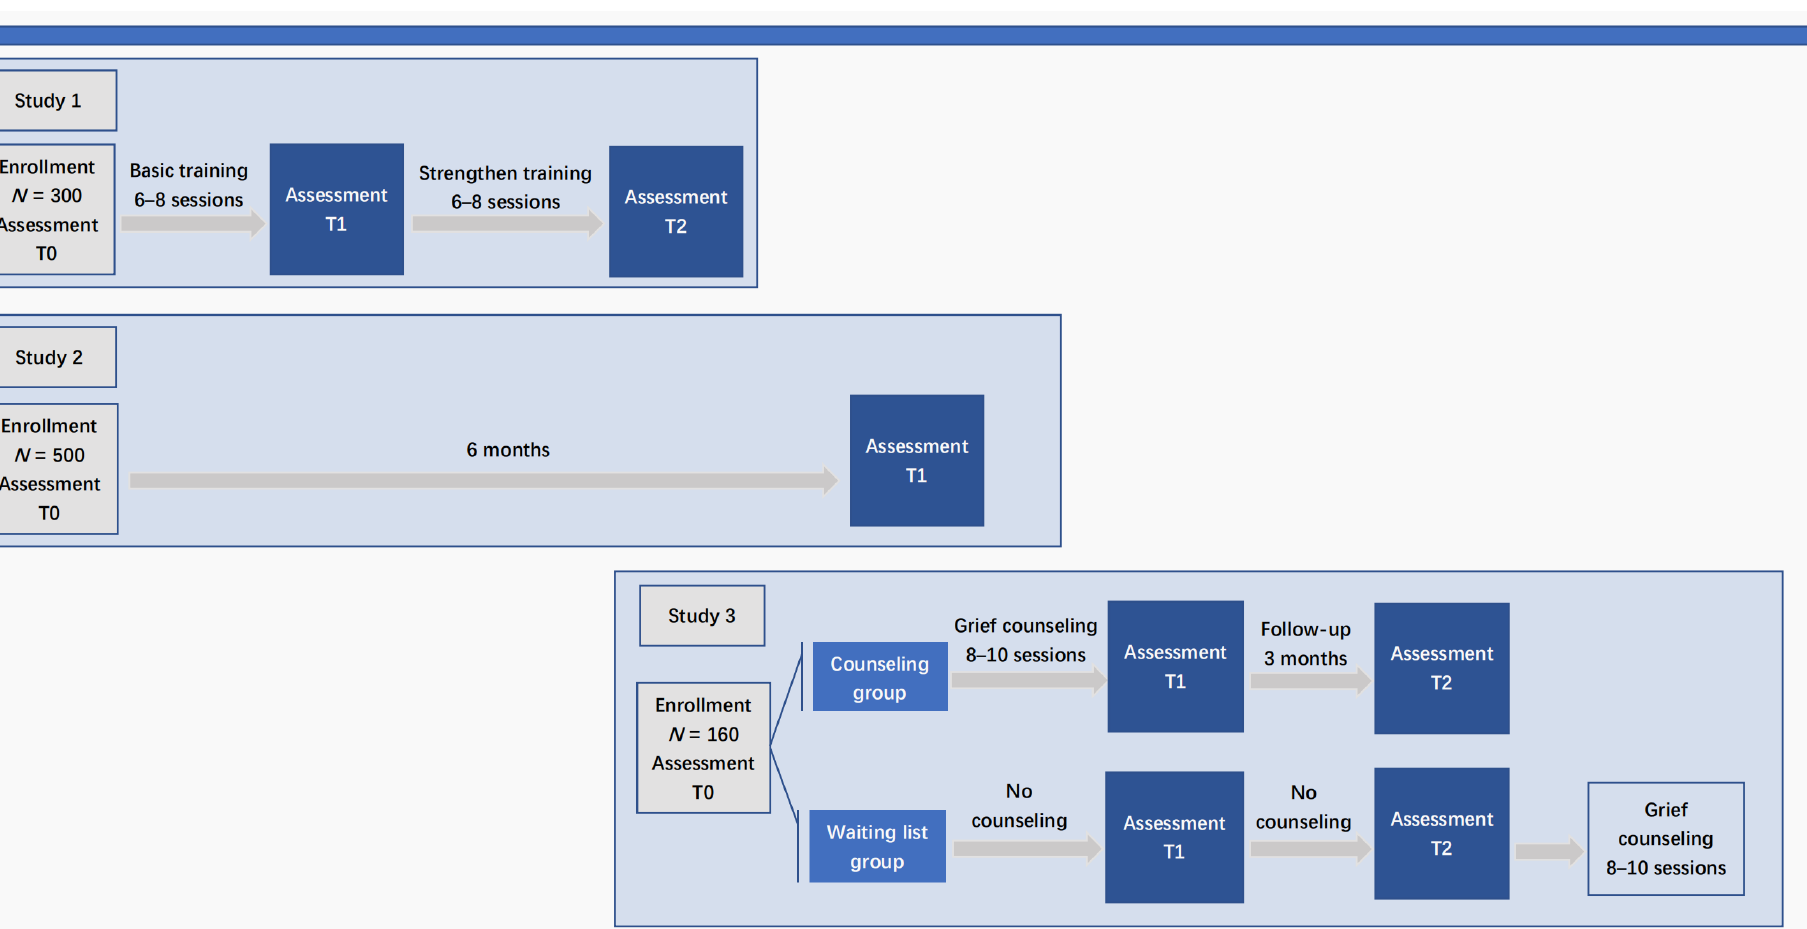
Figure 1. Study design.